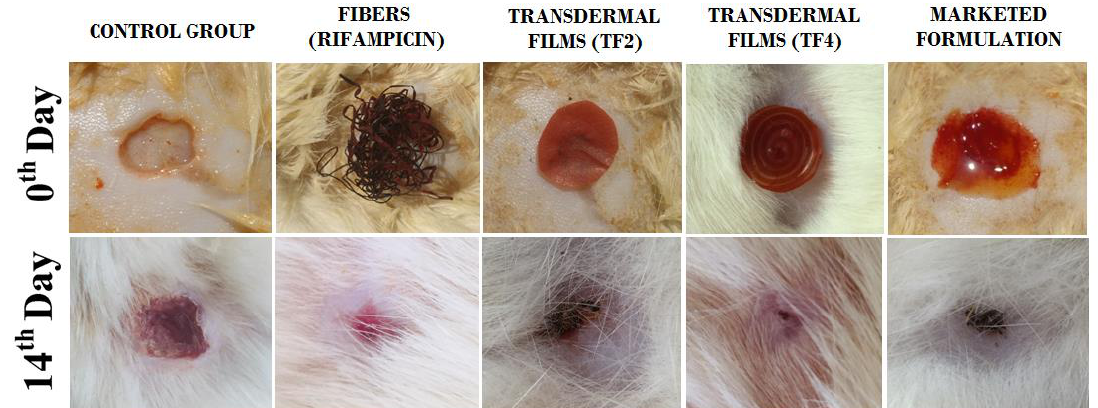
Figure 8. Wound healing process on the 0th and the 14th day of treatment with control group, fibers (Rifampicin), transdermal films (TF2), transdermal films (TF3) and marketed formulation (Povidone).